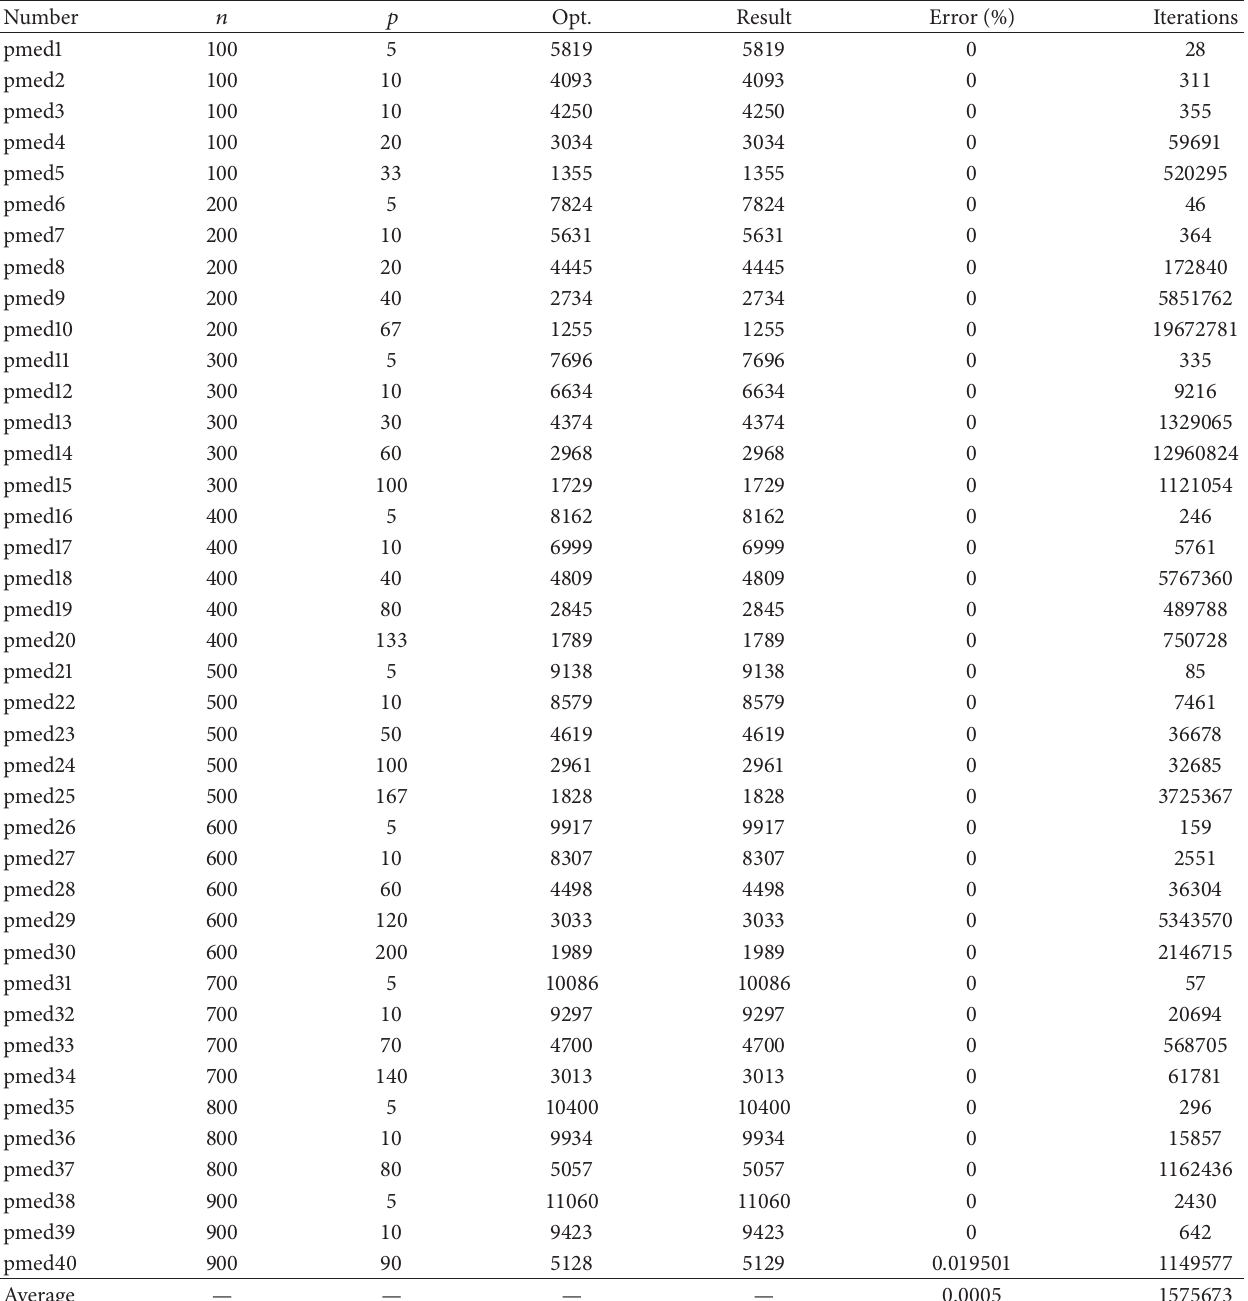
Table 1: The computational results for the ORLIB pmed1–40